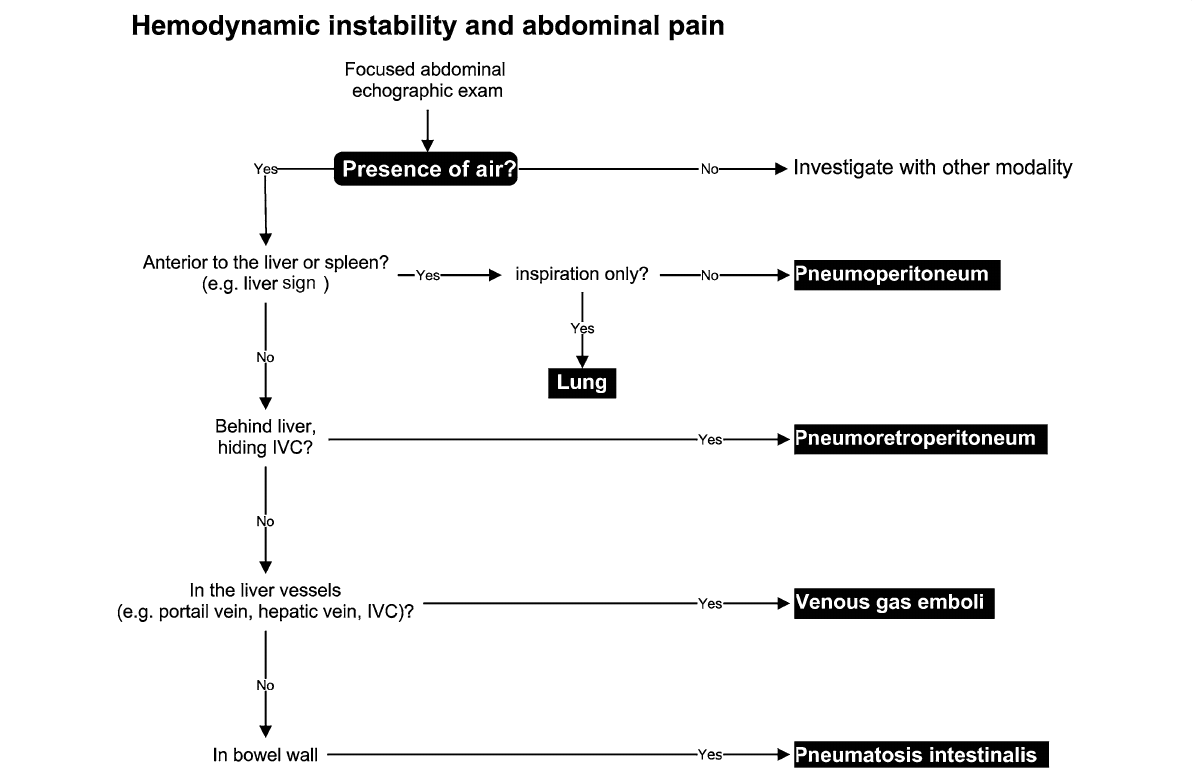
Fig. 5 Proposed approach using bedside ultrasound for patients with abdominal pain and hemodynamic instability. If air is present anterior to the liver or spleen (in the absence of a recent abdominal surgery) during both inspiration and expiration, a pneumoperitoneum should be suspected. A pneumoretroperitoneum will be associated with air behind the liver hiding the inferior vena cava (IVC). Venous gas embolism will be associated with air in the liver typically in the portal vein mostly in the peripheral regions of the liver. Air embolism can also be seen in the hepatic vein and the IVC. Finally pneumatosis intestinalis is characterized by air in the bowel